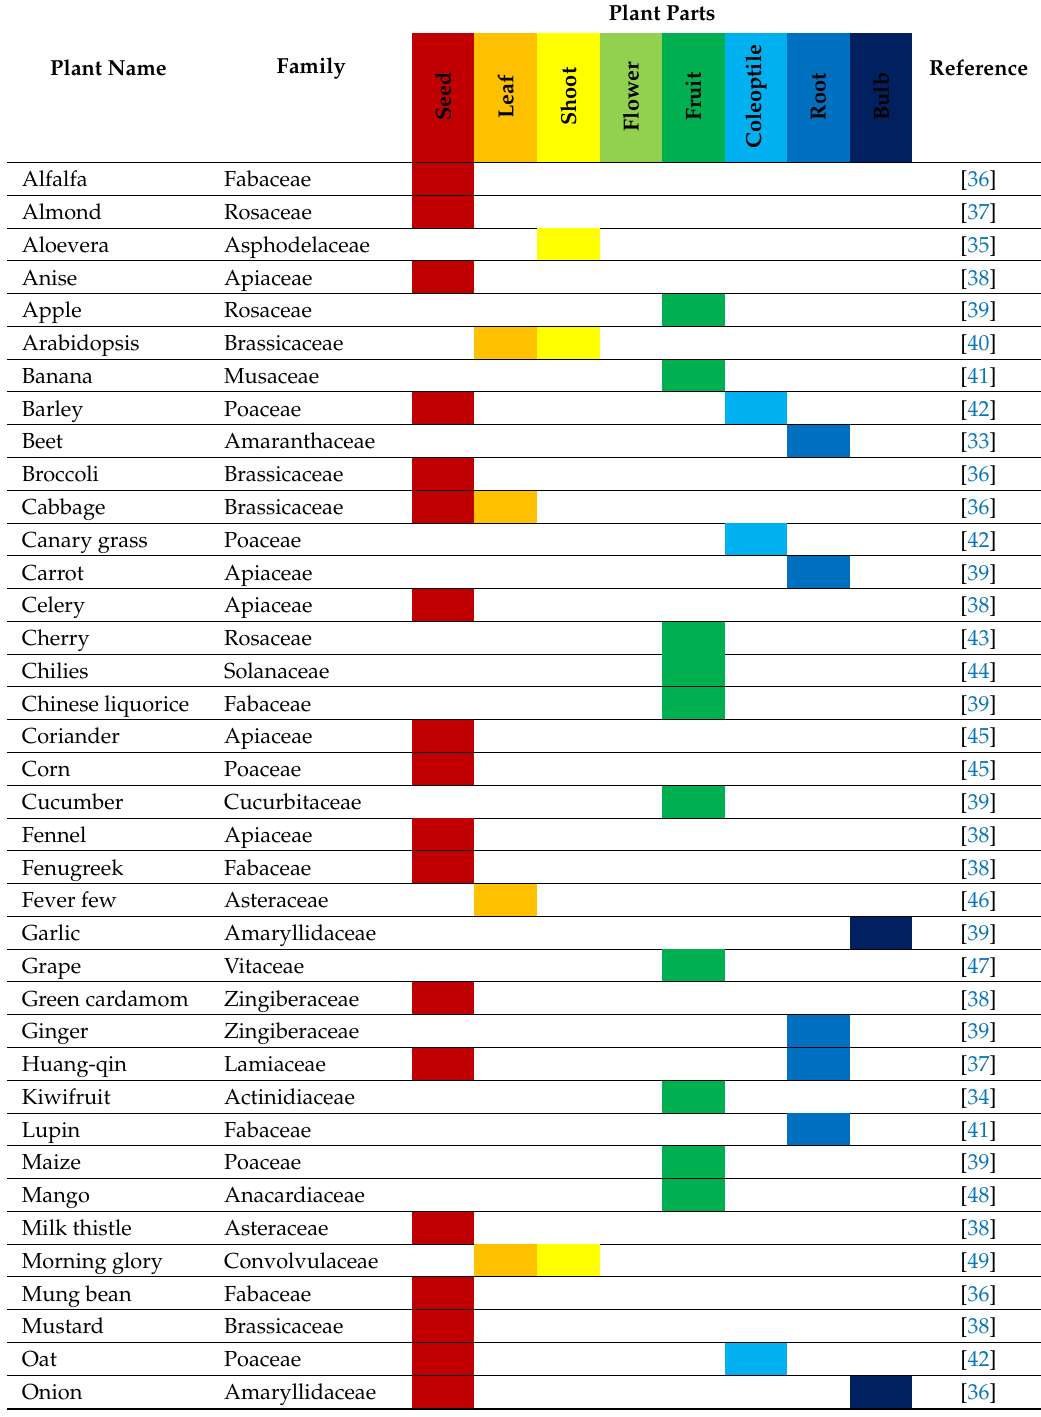
Table 1. Availability of melatonin in different plant